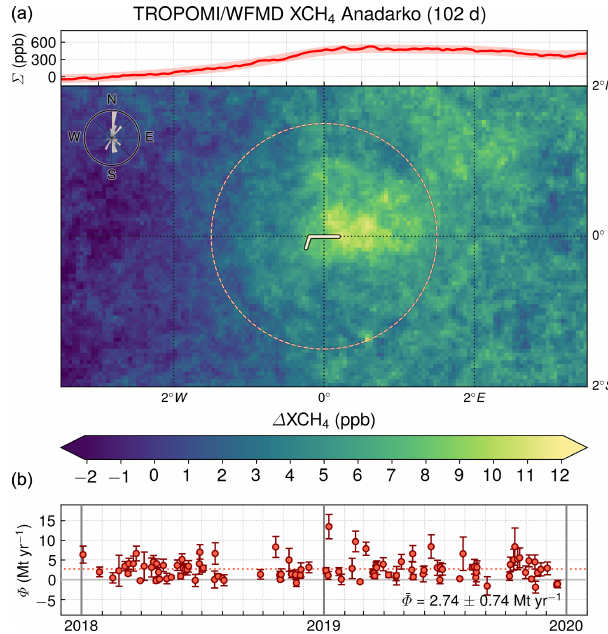
Figure 10. As Figs. 4, 5, 7, and 8 but for the Anadarko Basin. The coordinates of the pivotal point are 36 ◦ N, 98 ◦ W. The mean emission estimate (cid:56) corresponds to a fugitive emission rate of 3 . 9 ± 1 .